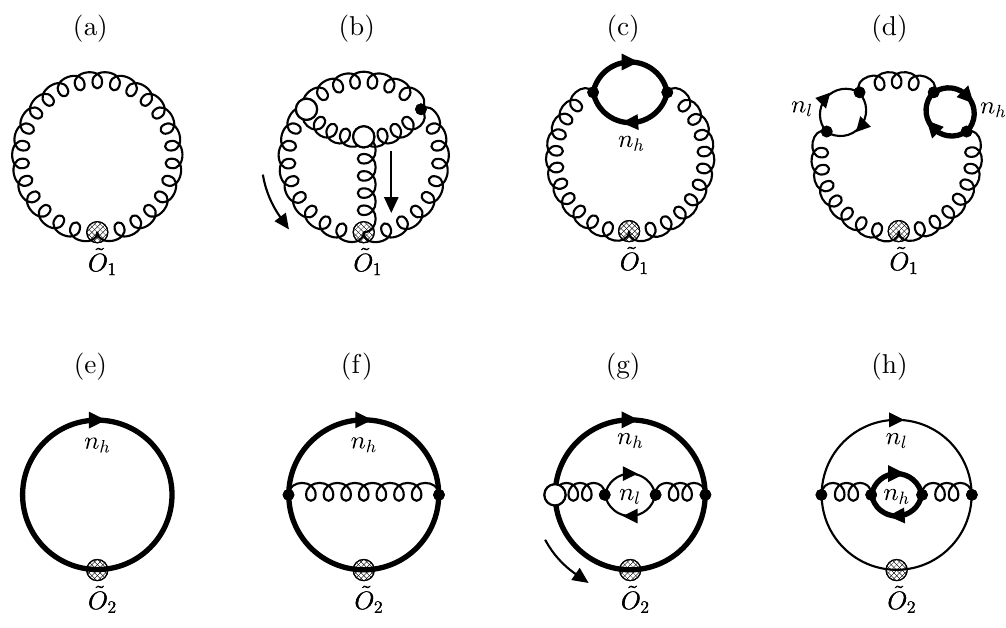
Figure 2 . Sample diagrams contributing to (cid:16) ( m ) n ( m 2 f 0 ; 2 g ) and (cid:16) n 3 , for n = 1 (a-d) and n = 2 (e-h). The notation is the same as in (cid:12)gure 1; in addition, white circles denote (cid:13)ow-vertices, and lines with arrows next to them denote (cid:13)ow-lines (see ref. [65] for details). Diagrams (a) and (b) only contribute to (cid:16) (0) 1